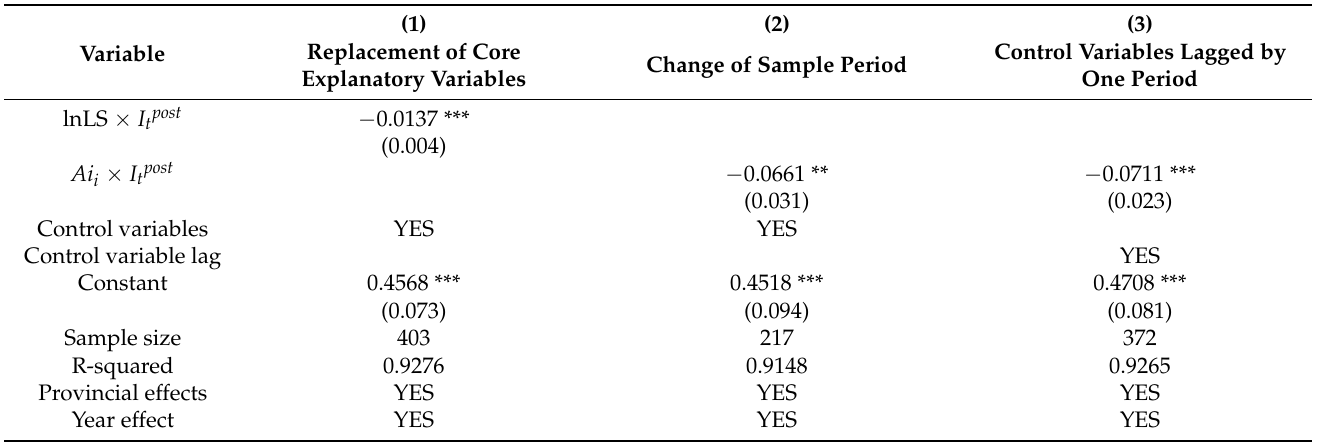
Table 4. Robustness test